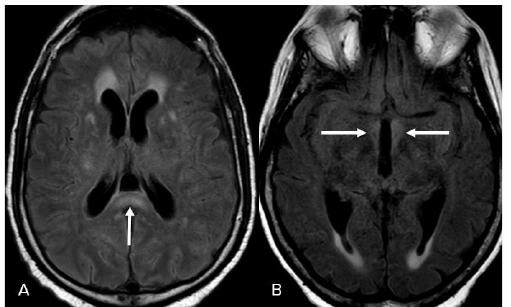
Figure 9. Less common patterns. ( A ) Axial FLAIR images show FLAIR hyperintensity of the sple- nium of the corpus callosum. ( B ) FLAIR hyperintensity around the third ventricle. Image has been windowed manually to improve the visibility of signal abnormality.